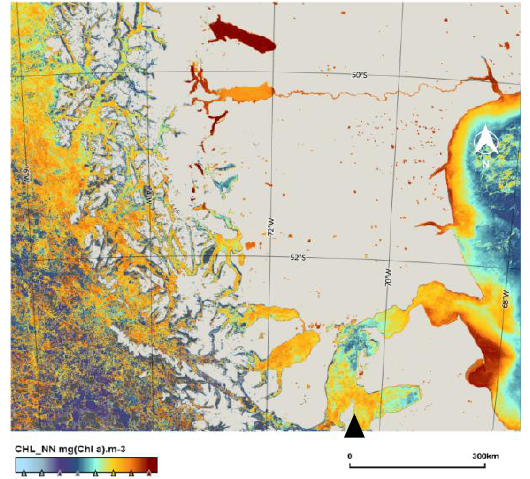
Fig. 4. Spatial distribution of Chlorophyll a and suspended organic matter in the Magellan región and along Magellan Strait during 2019. Black arrow showing Dawson Island. Bar scale: 200 km (Elaborated by X. Aguilar).